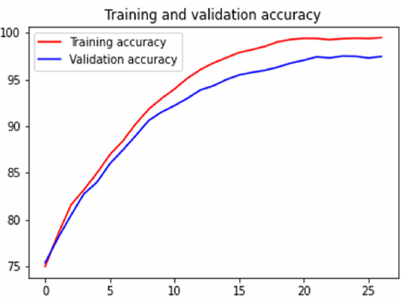
Figure 13. Training and validation accuracy vs. epoch for 4-class image classification.